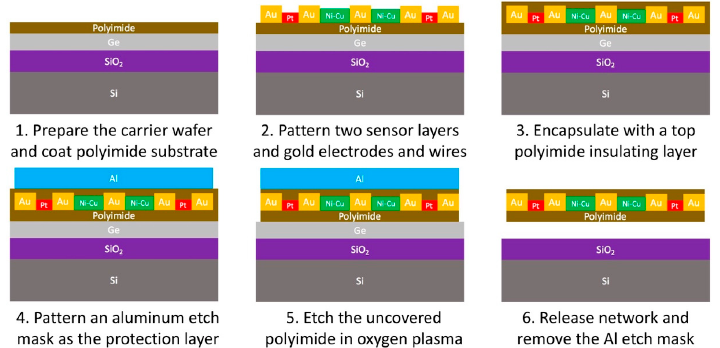
Figure 5. Fabrication process flow of the multifunctional stretchable sensor network.